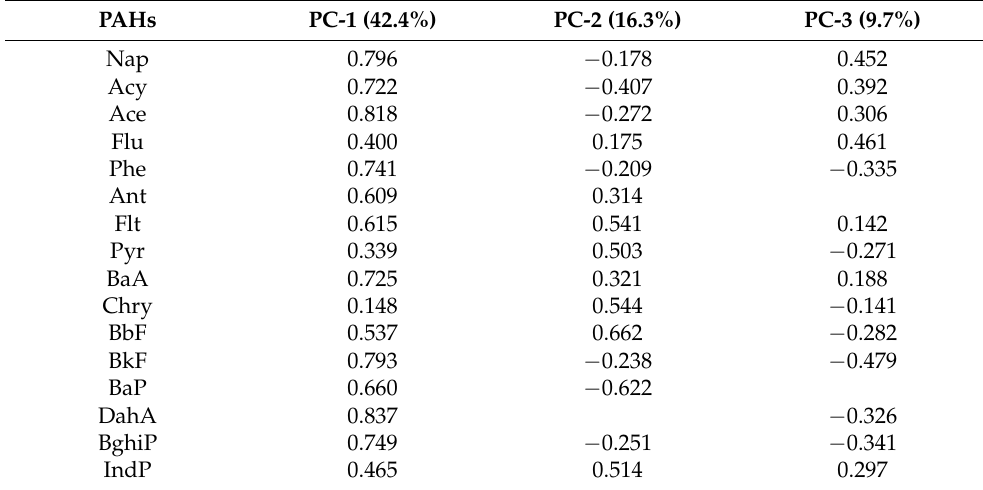
Table 5. Extracted principal components PC-1, PC-2 and PC-3 analyses of the sediment samples.